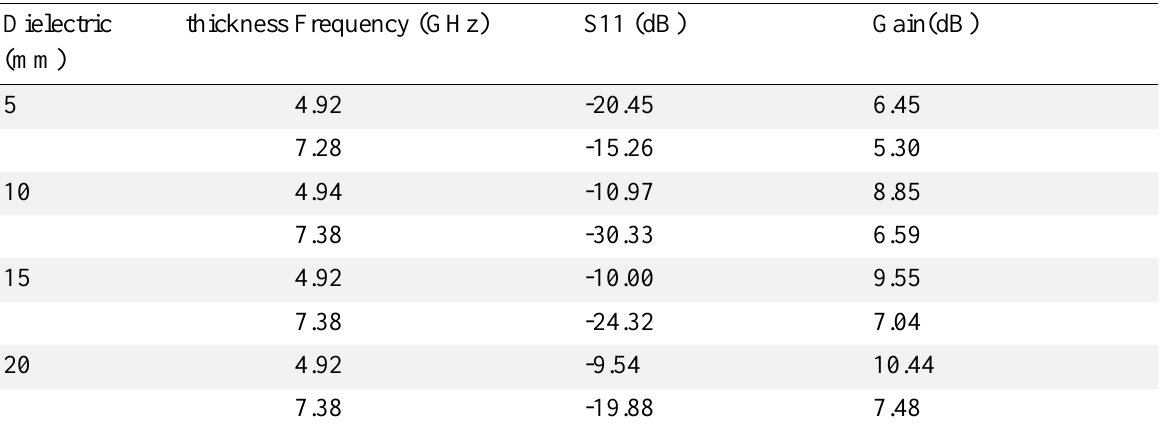
Table 3. Changing dielectric thickness 1 Dielectric